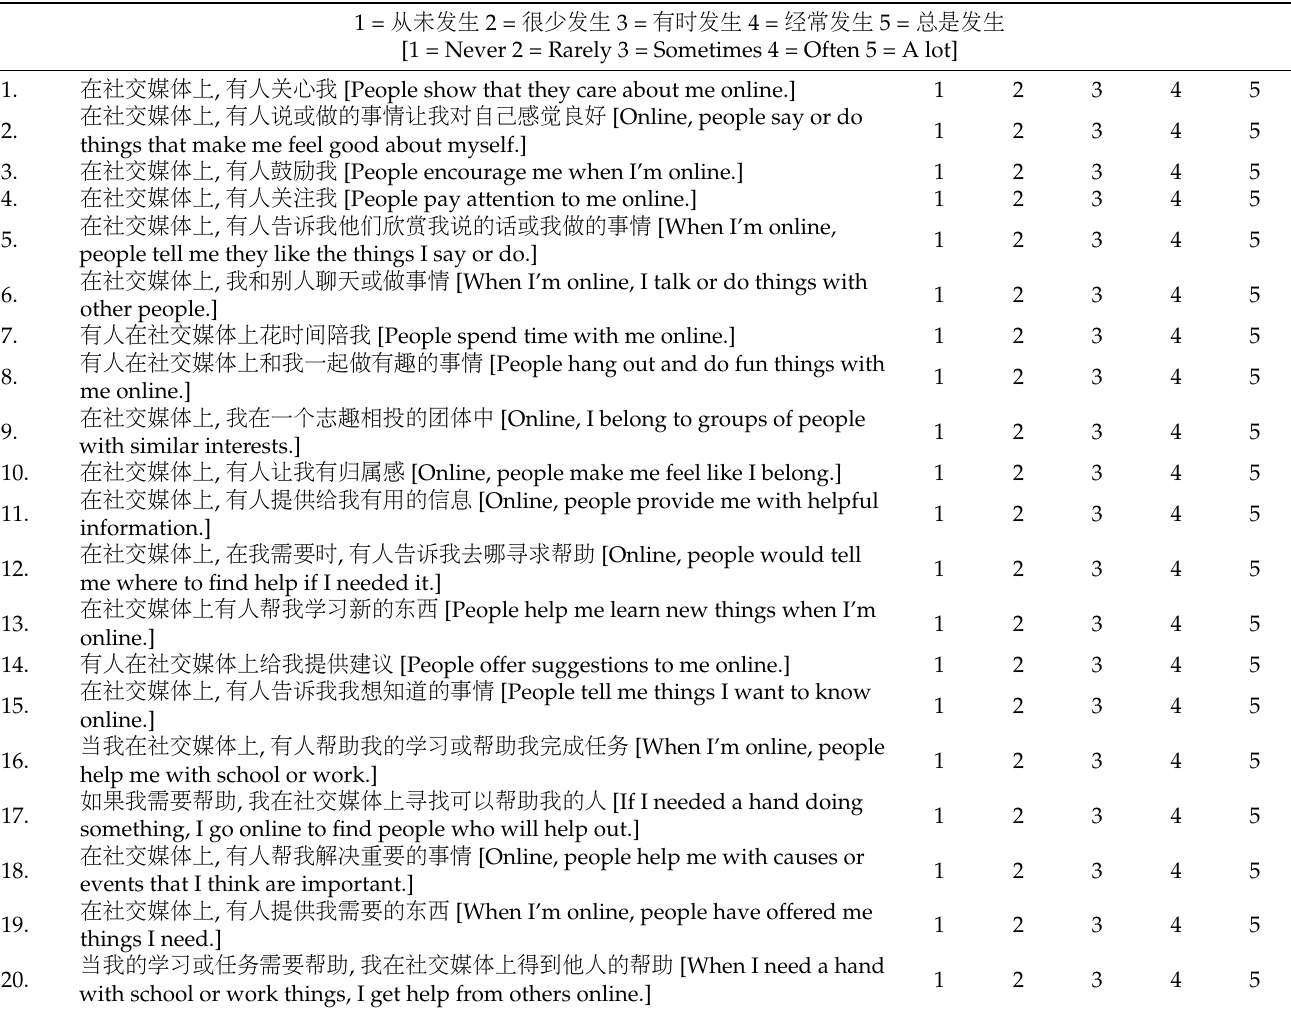
Table A1. Online Social Support Scale—Chinese Short